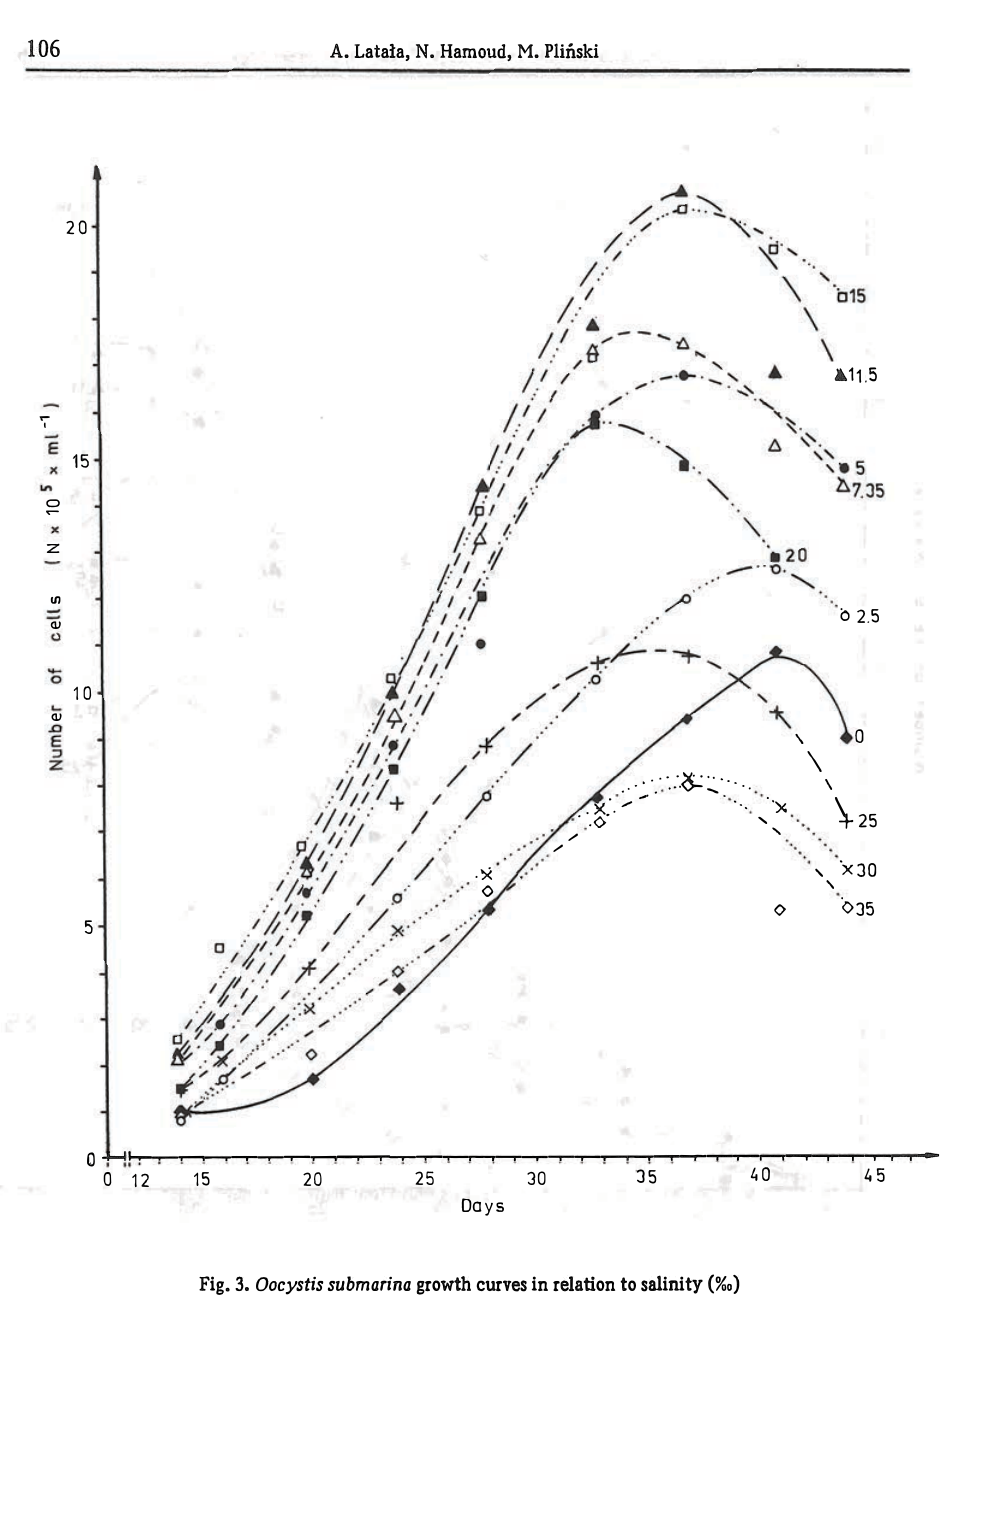
Fig. 3. Oocyst is submarina growt h c u rv e s in rel ation t o salini